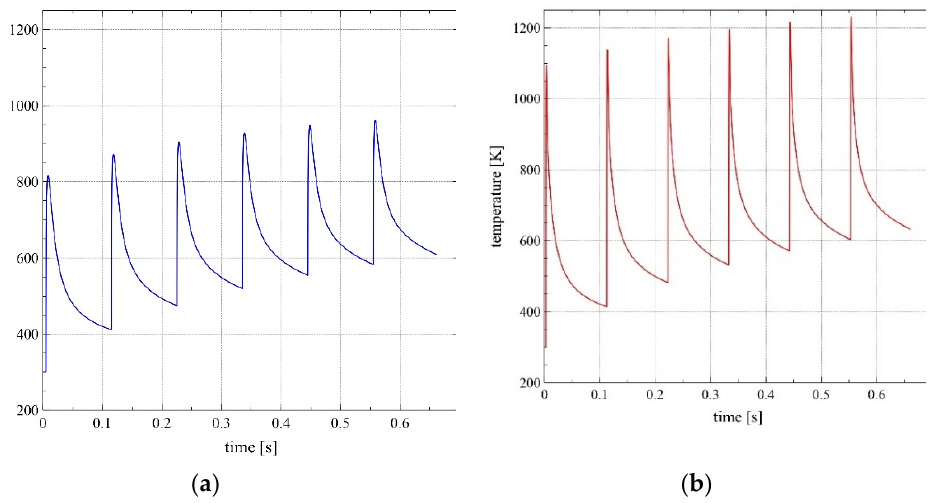
Figure 17. Time courses of the temperature at the internal barrel surface for validation cross-section ( a ) and the most loaded cross-section ( b ).